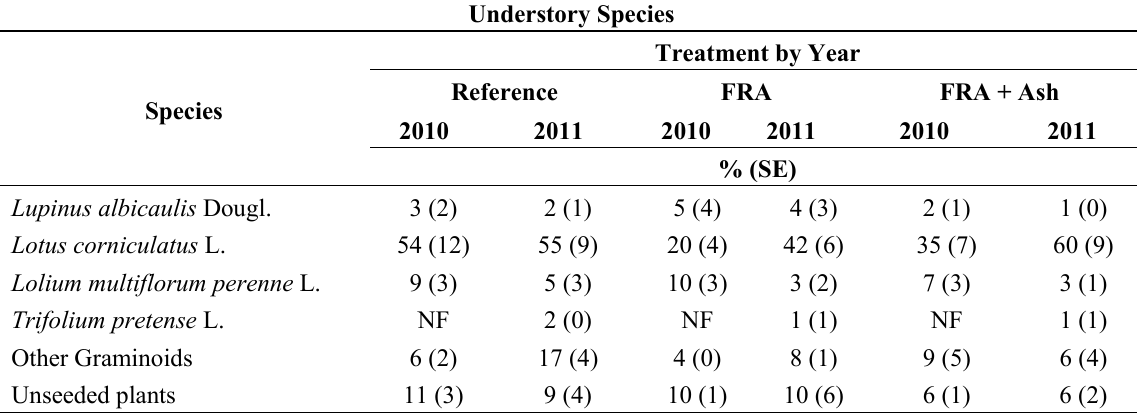
Table 5. Mean abundance of some understory species by treatment and year, with standard error of the mean in parentheses. Reference is the standard mine reclamation technique, FRA is the modified Forestry Reclamation Approach, and FRA + Ash is the modified Forestry Reclamation Approach with an addition of bottom ash from the on-site coal burning power plant. In some cases, species were not found in the treatment area (NF: not found; SE: standard error). Understory Species Treatment by Year Reference FRA FRA + Ash Species 2010 2011 2010 2011 2010 2011 %